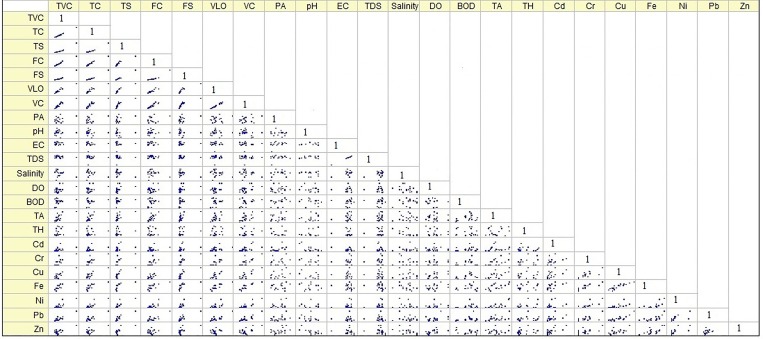
Scatter matrix plot for interrelationship of microbial, physiochemical and trace.